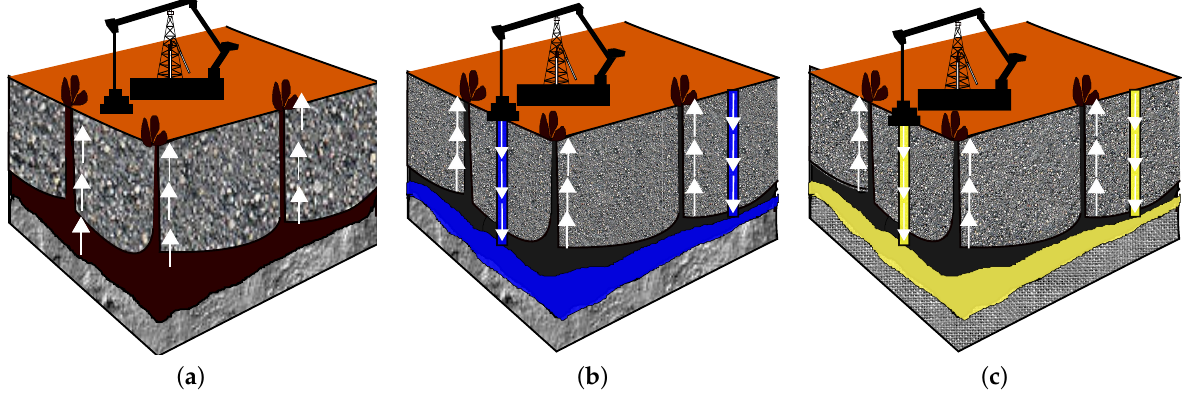
Figure 1. Oil recovery steps: ( a ) Initial oil recovery; ( b ) secondary oil recovery; ( c ) tertiary oil